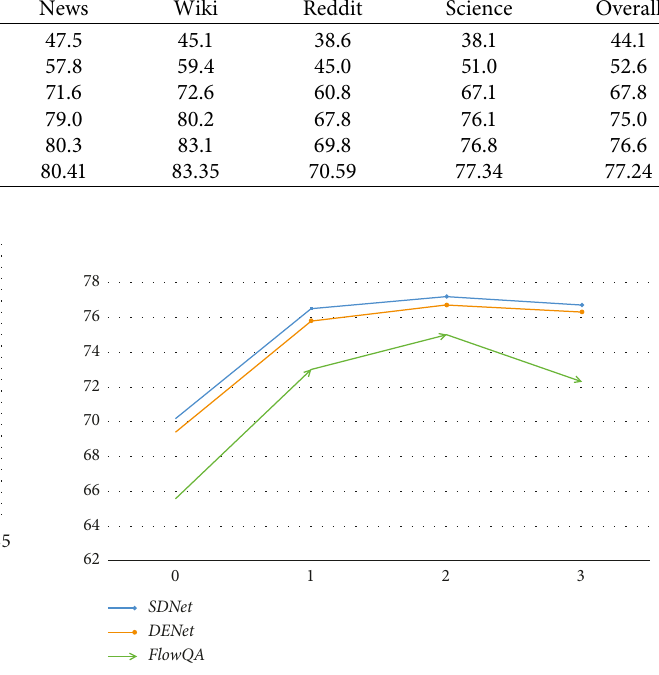
Figure 5: Feature extraction model structure.